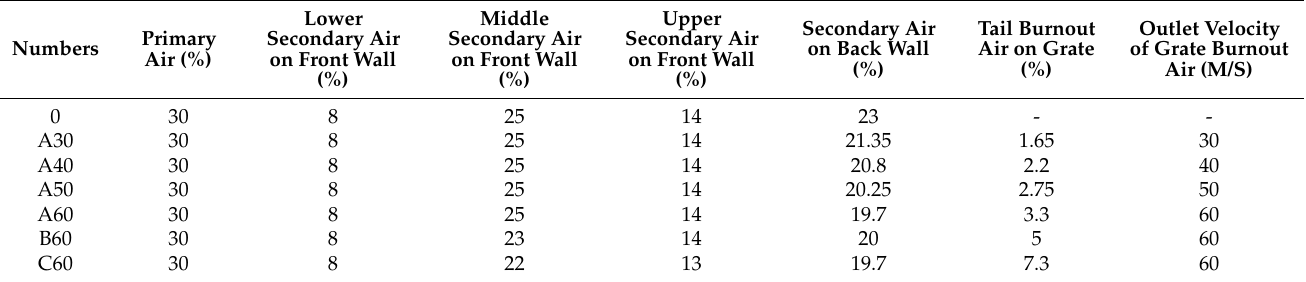
Table 3. Air distribution condition of boiler cold flow